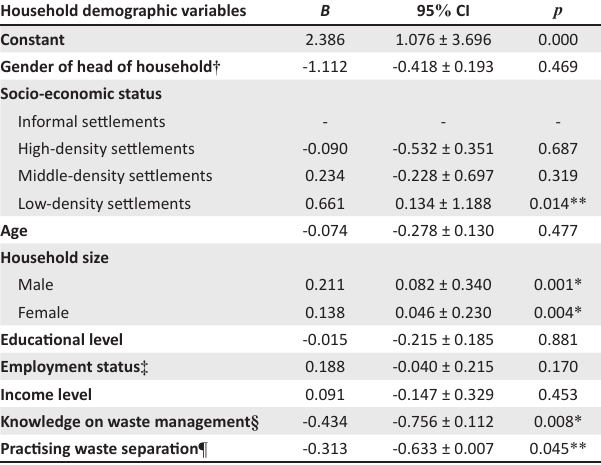
TABLE 6: Multiple regression analysis of drivers of household waste generation in Mthatha, South Africa ( N = 248). Household demographic